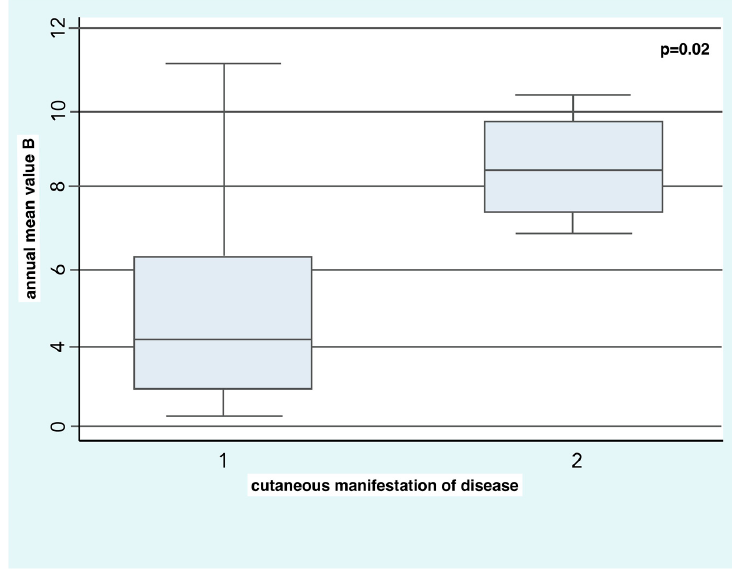
Figure 1. Box plot of mean annual Benzene (B) concentration in patients with diffuse skin disease and limited skin disease ( p = 0.02).